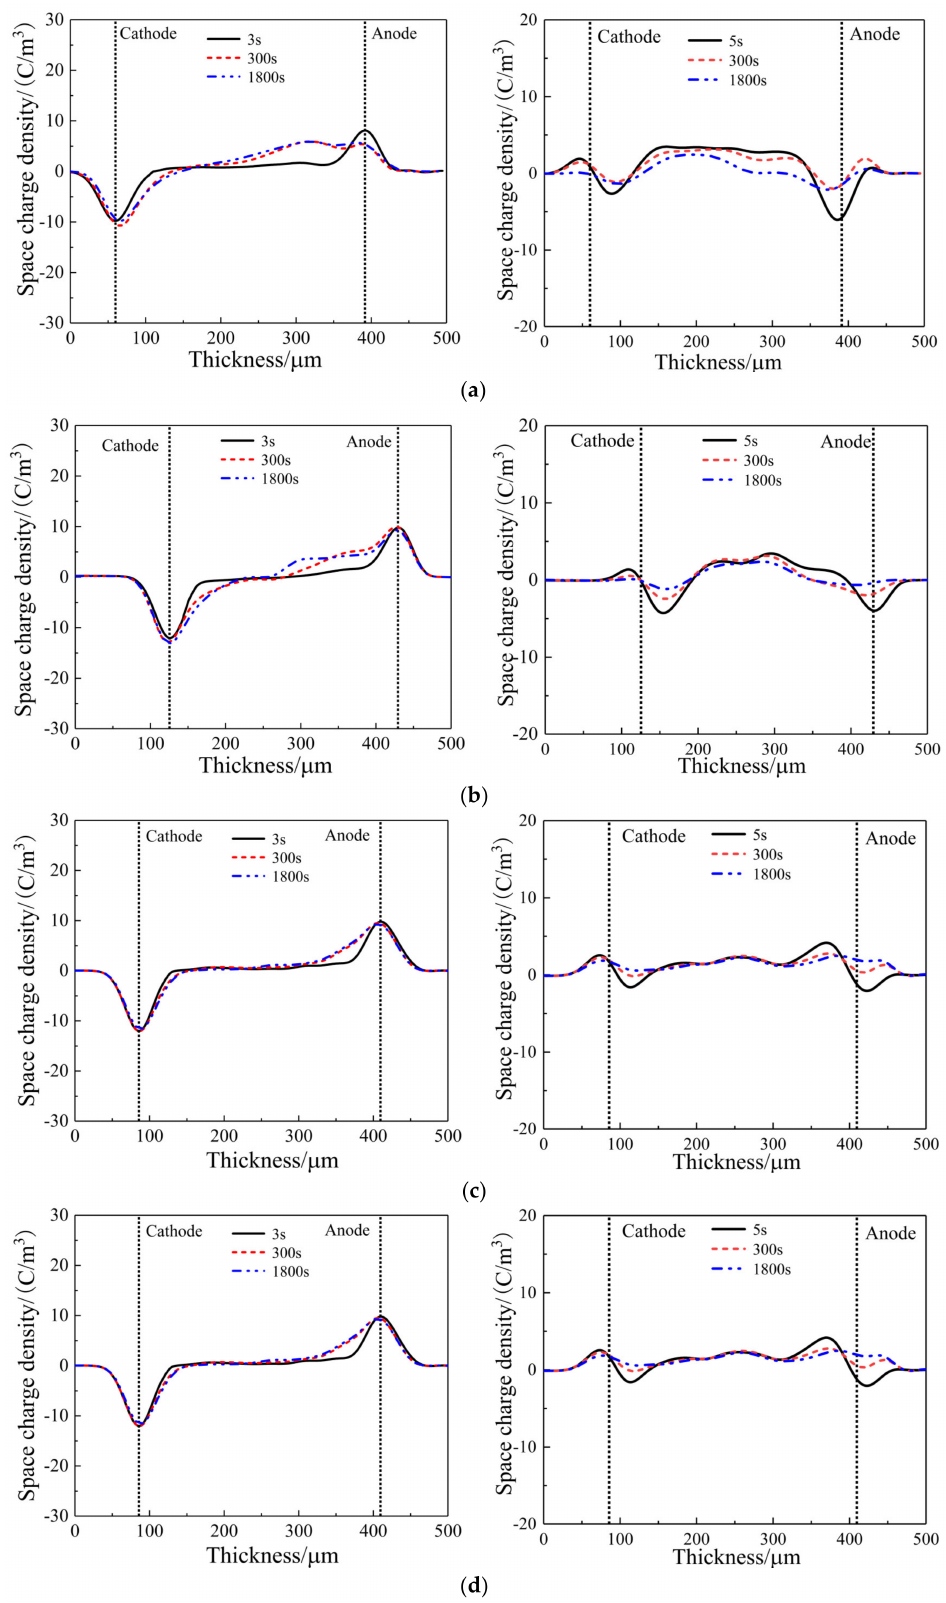
Figure 6. Space charge distribution in: ( a ) pure LSR; ( b ) 5 wt%; ( c ) 10 wt%; and ( d ) 20 wt% SiC contents in the polarization process of applying voltage (left panels) and in the depolarization process under a short-circuit (right